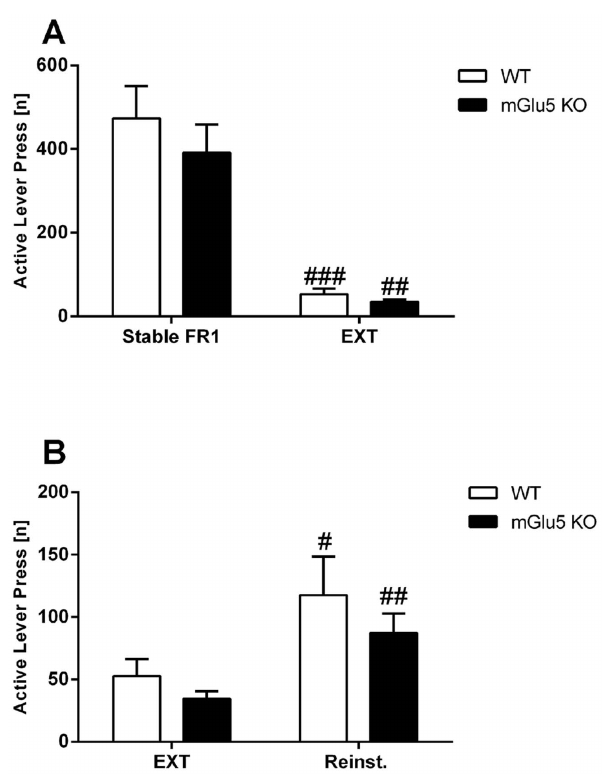
Figure 4. Extinction and reinstatement of the operant response for sucrose. A) Average active lever presses during Stable FR1 and the final 2 days of extinction. Both genotypes significantly decreased their active lever presses during both days of extinction. B) Average active lever presses during extinction and cue-induced reinstatement. Both genotypes increased their active lever pressing in the reinstatement test following extinction. Data (mean 6 SEM) analysed using two-way RM ANOVA, followed by one-way ANOVA split by the factor ‘genotype’ with a Bonferroni correction. Significant effects of ‘day’ ( vs. Stable FR1) are represented by ‘‘ # ’’ ( ## p , .01; ### p , .001). Abbreviations: EXT - final extinction score; FR1– fixed ratio 1; Reinst - reinstatement.